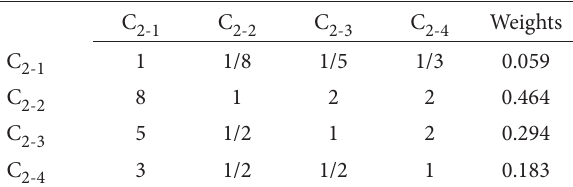
Table 8. Pairwise comparison matrix for Socio-economic factors and their weights